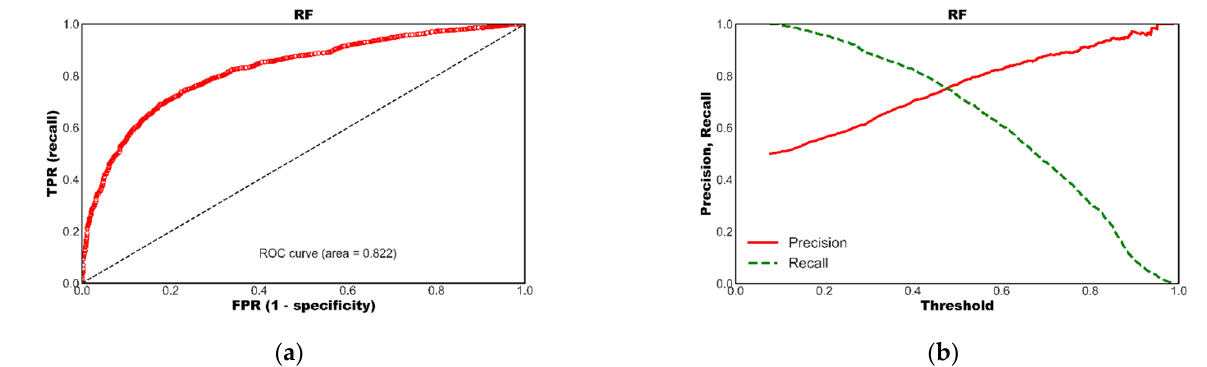
Figure 3. ROC ( a ) and Precision – Recall ( b ) curves obtained with the optimal RF. Table 1. Summary of the scores obtained on the test dataset with the different classification algo- rithms to detect observations higher than the median. Precision and Recall were obtained for a threshold of 0.5.